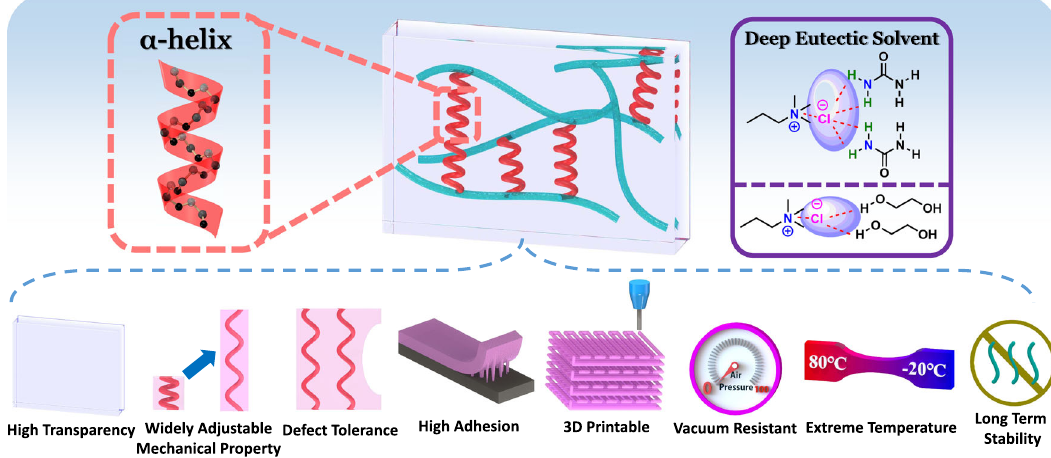
Fig. 1 | Schematic diagram of the structure and properties of peptide-enhanced eutectogel. The gel exhibits high toughness, high resilience, high adhesion, anti- drying, and anti-freezing properties